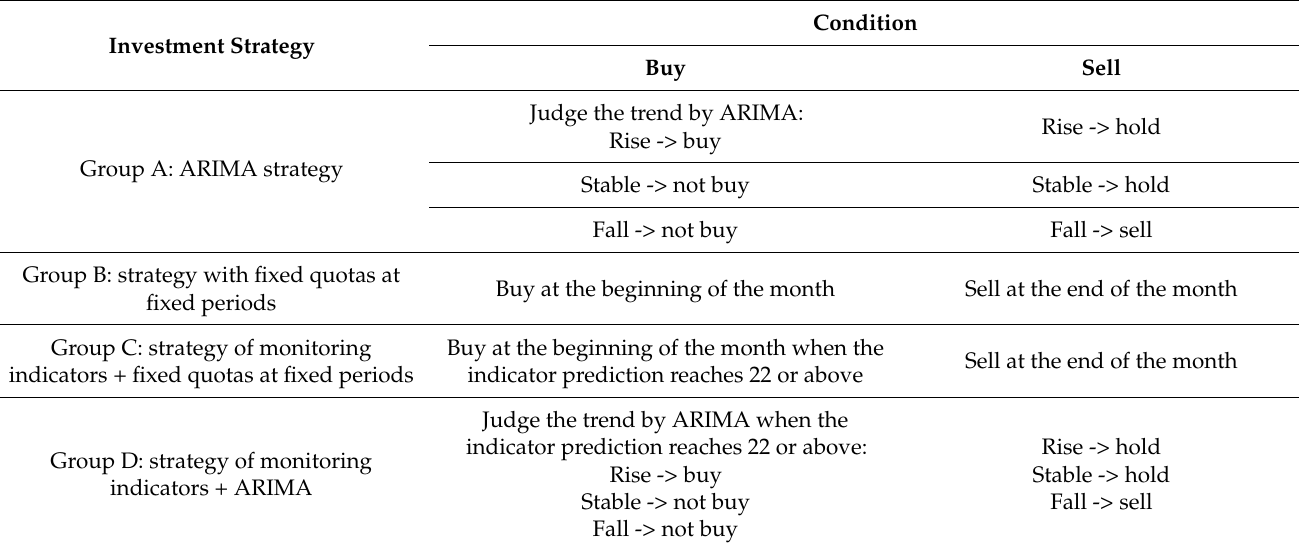
Table 1. Investment strategy